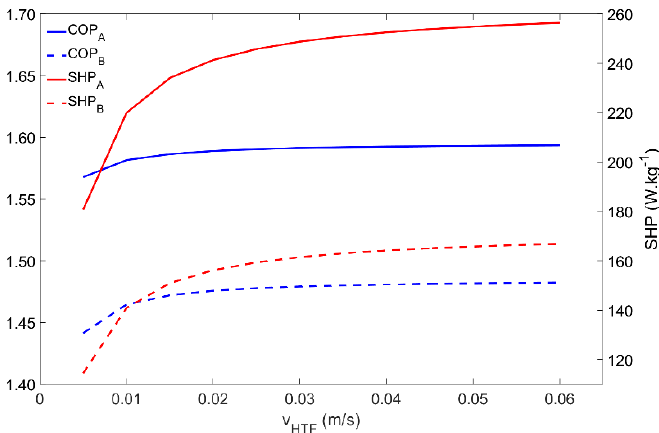
Figure 10. Influence of the heat transfer fluid’s velocity on the adsorber performance for scenarios A and